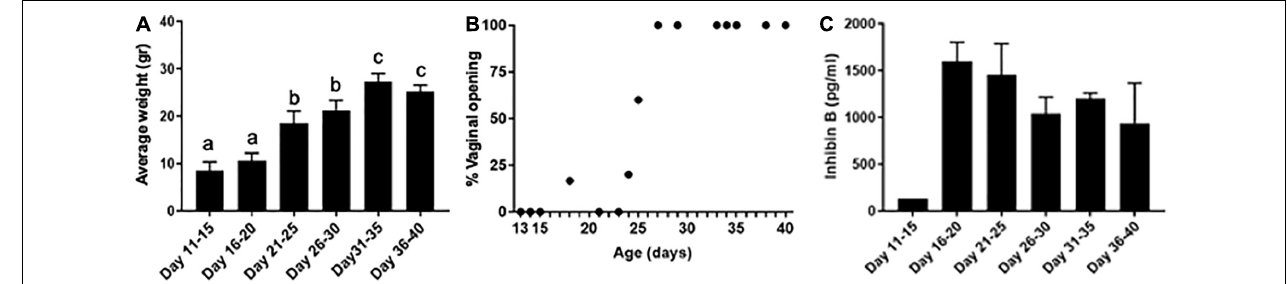
FIGURE 1 | Pubertal transition in mice as characterized by changes in weight, vaginal opening, and inhibin B levels. (A) Average mouse weight in different age cohorts was measured across pubertal transition ( n = 42, 5—9 mice per age cohort). Error bars represent standard error of the mean (SEM). Columns with different letterheads are significantly different from each other ( p < 0.001). (B) Percent of mice with vaginal opening was tracked at different ages spanning pubertal transition ( n = 39). Mice were not tracked longitudinally; instead, mice within each age cohort represented distinct biological replicates and were euthanized immediately following the evaluation of vaginal opening. (C) Serum inhibin B levels were measured in mice across pubertal transition ( n = 21 mice, 3–5 mice per age cohort—one pooled serum sample from 5 mice was tested for PND 11–15, and individual serum samples were used in other age